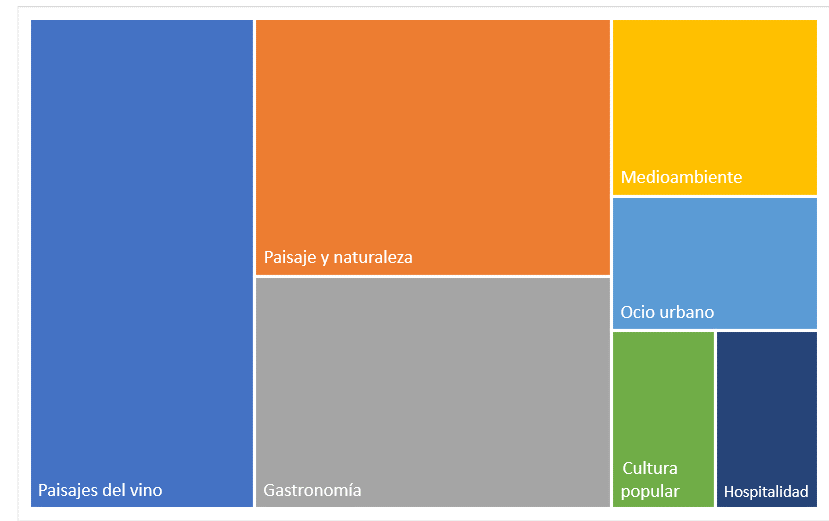
Figure 10. Emotional values of the Lanzarote AO. Source: Own elaboration.